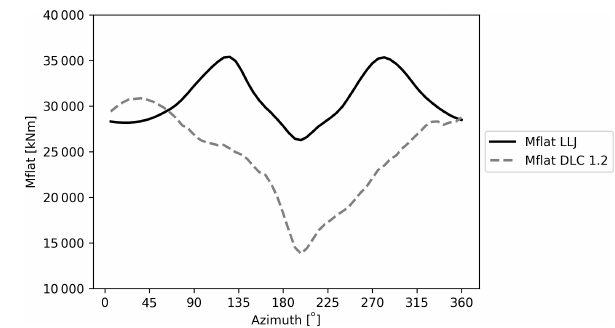
Figure 11. Azimuthally binned averaged flatwise moment: LLJ versus DLC